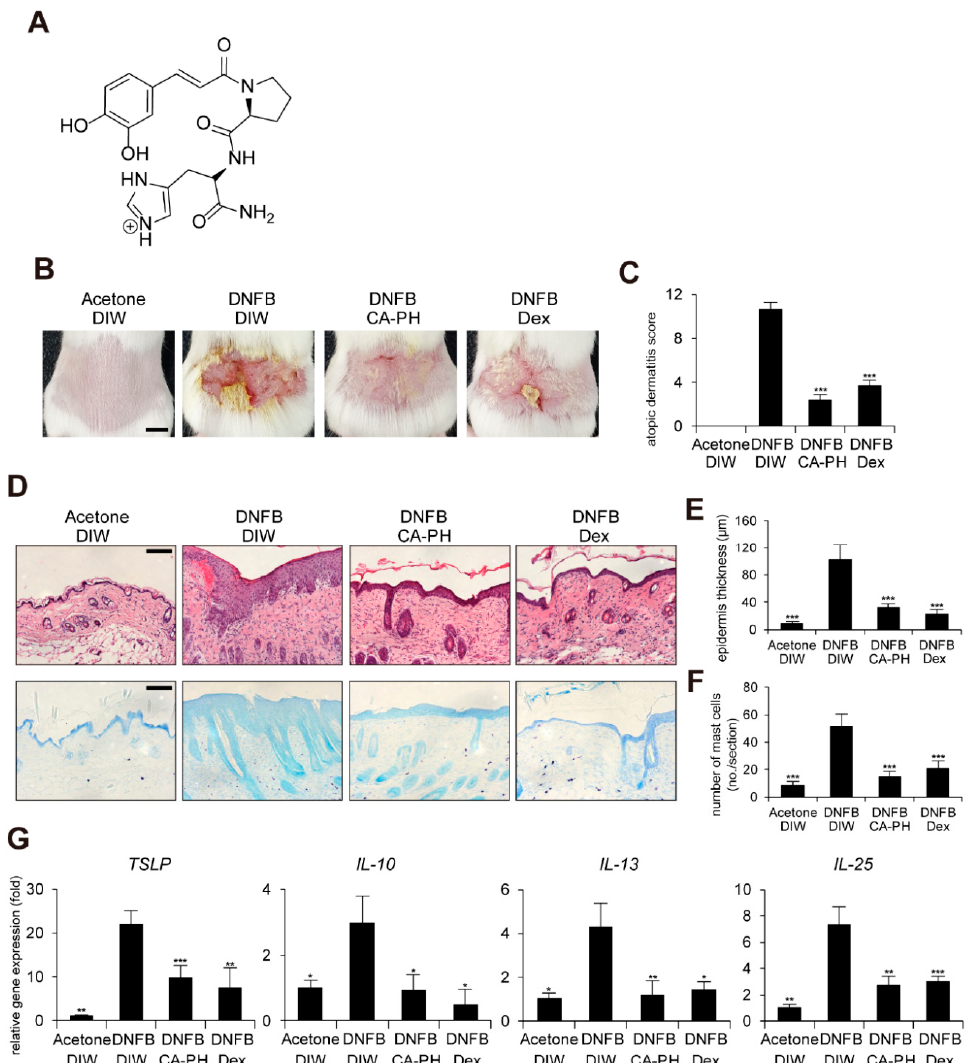
Figure 1. CA-PH alleviates AD-like phenotypes induced by DNFB treatment. Topical application of CA-PH alleviates AD-like phenotypes induced by DNFB treatment in mouse skin. Dex was used as the positive control. Acetone and DIW were used as solvents for DNFB and CA-PH, respectively. ( A ) Structure of CA-PH. ( B ) After mice were sensitized with DNFB for 7 days, DNFB was further topically applied to the shaved dorsal skin with or without CA-PH for 12 days ( n = 6 / group). Mice were photographed and skin tissues were harvested. Representative images are shown. Scale bar, 0.5 cm ( C ) CA-PH alleviates the severity of AD-like phenotypes induced by DNFB treatment in mouse skin. The severity of dermatitis was determined by a scoring index of AD (see Material and Methods). ( D ) Tissue sections from the back skin were stained with hematoxylin and eosin (H&E) or toluidine blue (TB). Representative images are shown. Scale bar, 50 μ m. ( E ) CA-PH suppresses the increased epidermis thickness induced by DNFB treatment in mouse skin. Epidermis thicknesses were measured ( n = 6/group). ( F ) CA-PH suppresses infiltration of mast cells induced by DNFB treatment in mouse skin. The number of mast cells was counted from five randomly selected low-power fields ( n = 6 / group). ( G )CA-PHsuppressesDNFB-inducedup-regulationofcytokineexpressioninmouseskin. Transcriptsof TSLP, IL-10, IL-13, IL-25, and RPLP0 from mouse skin were quantified using real-time PCR ( n = 6 / group). All data represent means ± S.E.M. Significance values were * p ≤ 0.05, ** p ≤ 0.01, and *** p ≤ 0.005. Dex, dexamethasone; DIW, deionized